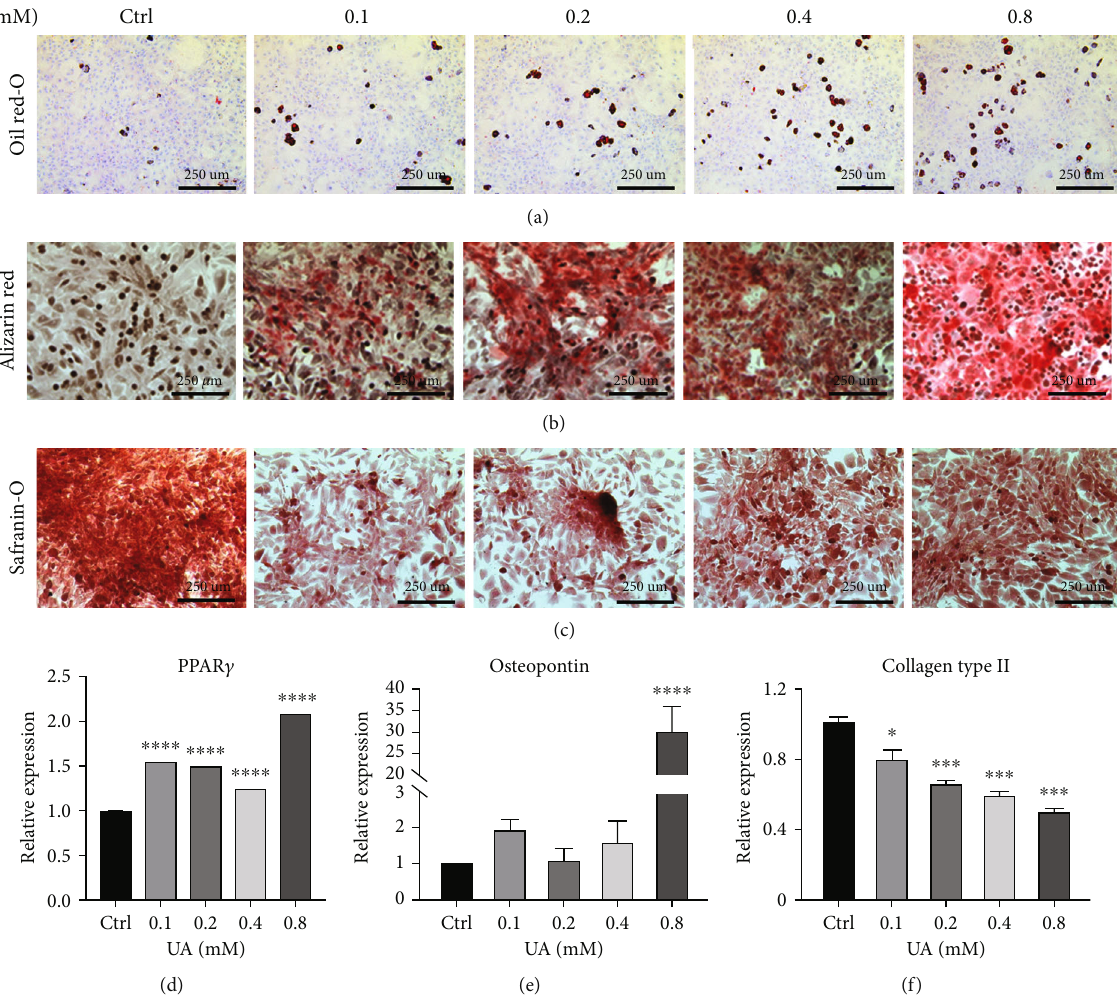
Figure 3: E ff ects of UA on the nontenocytic di ff erentiation of TSPCs. TSPCs were subjected to three types of di ff erentiation media with the addition of PBS or various concentrations of UA for 21 days. (a – c) Subsequent to the di ff erentiation course, oil red O staining (a), alizarin red staining (b), and safranin O staining (c) were performed to assess changes in adipogenesis, osteogenesis, and chondrogenesis of rat TSPCs, respectively. Representative images of each group show morphological alterations and visible changes in staining intensity ( n = 3 each). Bars = 250 μ m . (d – f) Real-time qPCR analysis was applied to determine expression of marker genes in TSPC postcomplete di ff erentiation. PPAR γ was used as the marker of adipogenic di ff erentiation (d), with osteopontin for osteogenic (e), and collagen type 2 for chondrogenic di ff erentiation (f). Values are the mean ± SEM from three independent experiments. Data were analyzed using two-way ANOVA. ∗ P < 0 : 05 ; ∗∗∗ P < 0 : 001 ; ∗∗∗∗ P < 0 : 0001 versus PBS-treated control within each